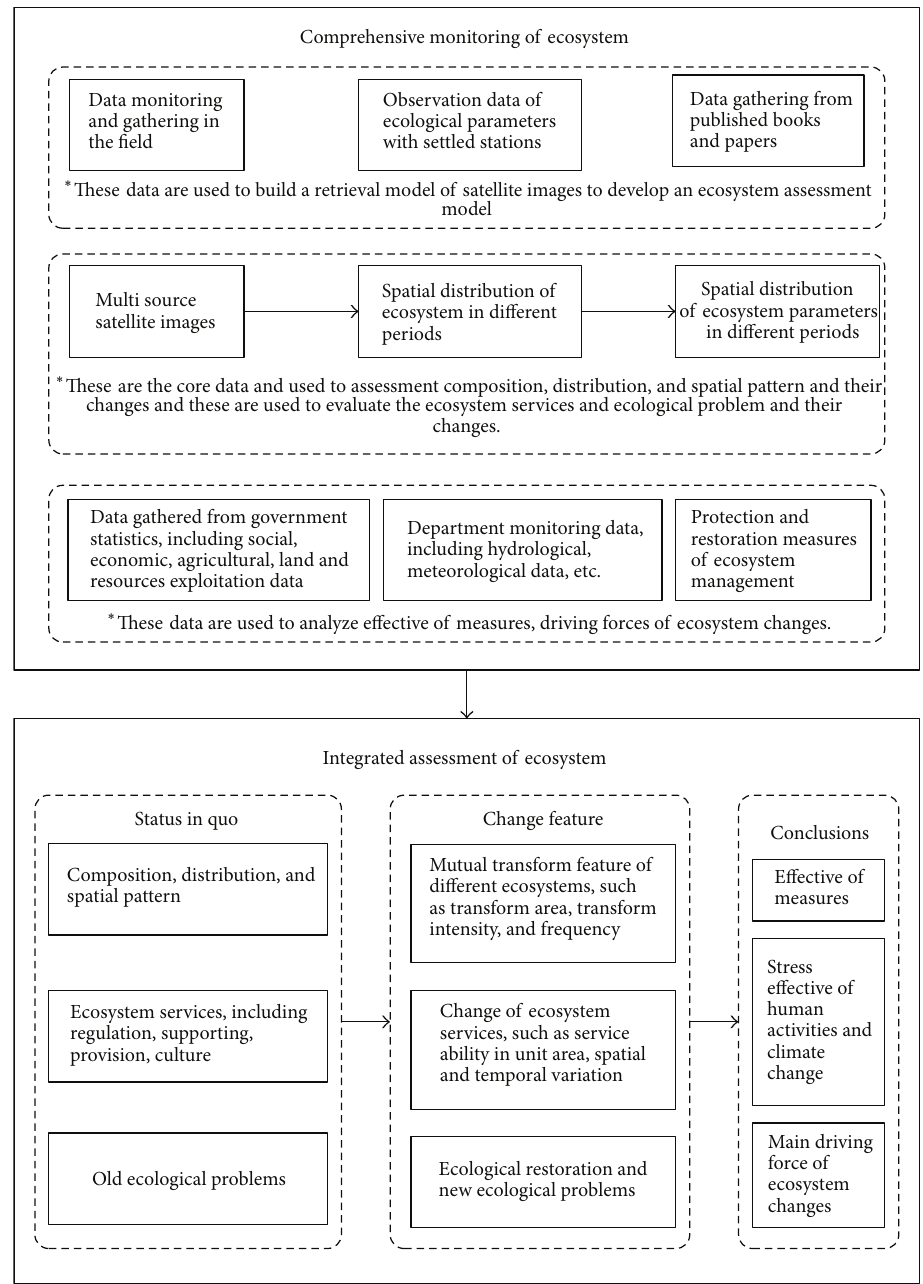
Figure 1: General framework of integrated ecosystem monitoring and